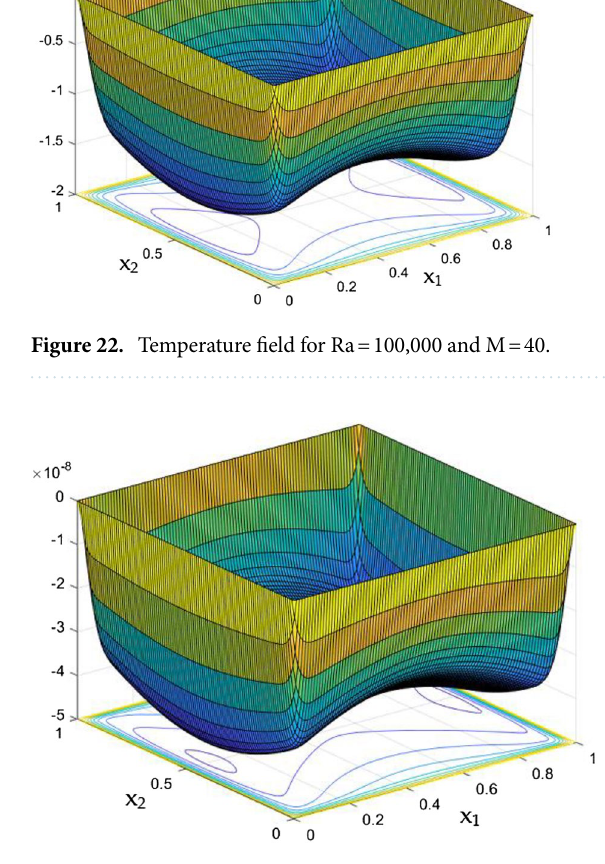
Figure 23. Temperature field for Ra = 100,000 and M = 60.